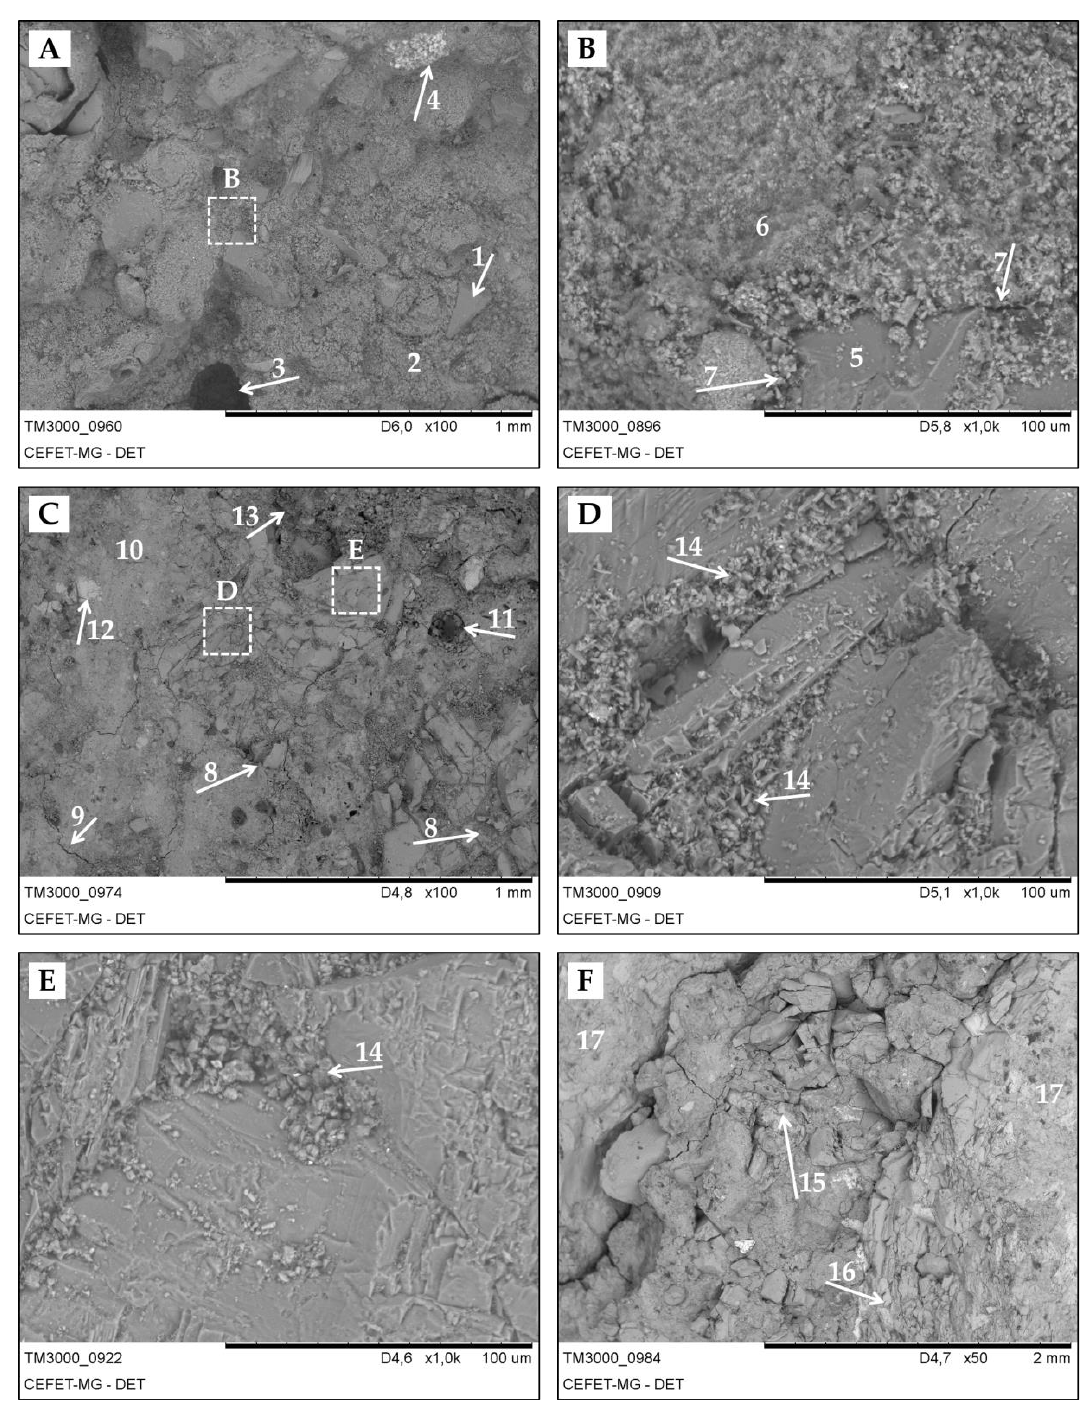
Figure 19. SEM images of binary binder concrete. ( a ) BBC-WCA - 100X; ( b ) BBC-WCA - 1000X; ( c )